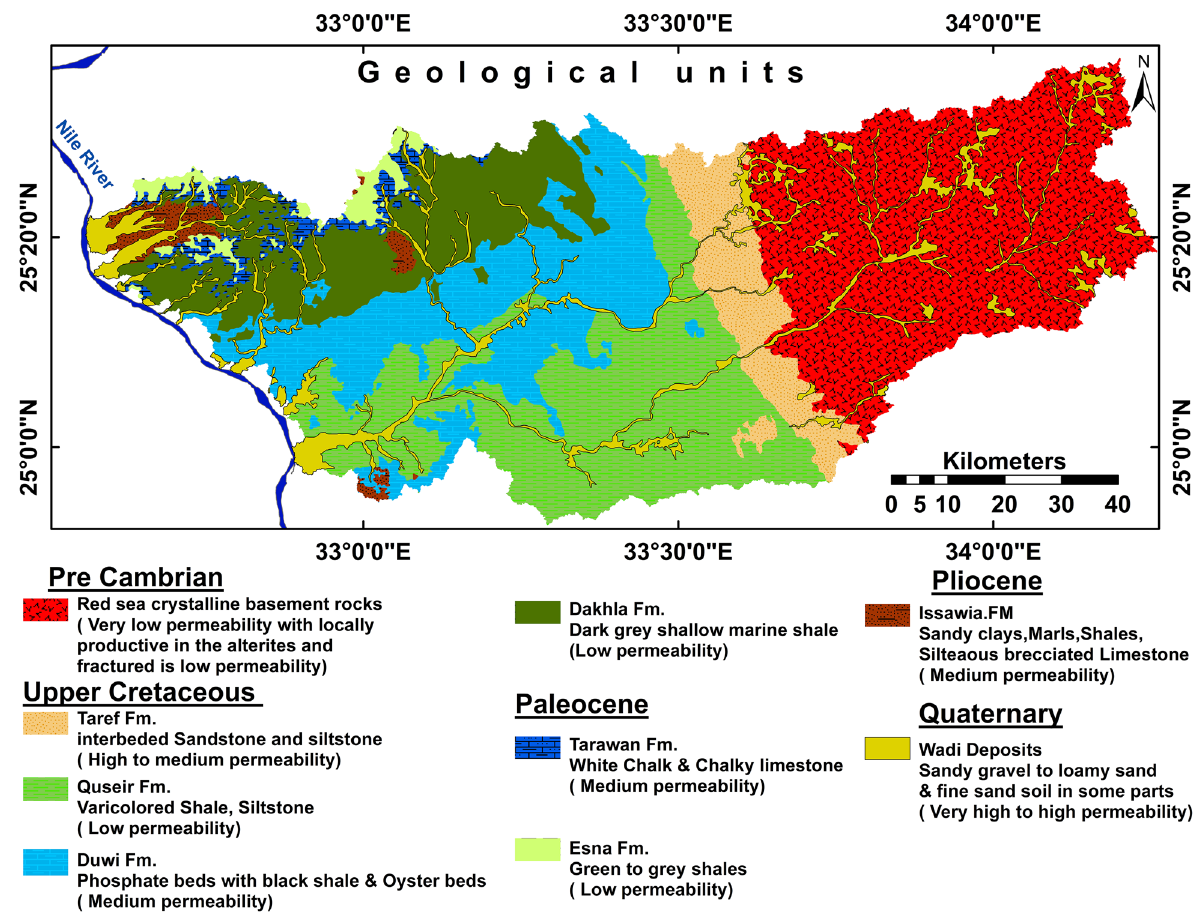
Fig. 2 The study area’s general geological units (Conco 1987) are associated with relative permeability